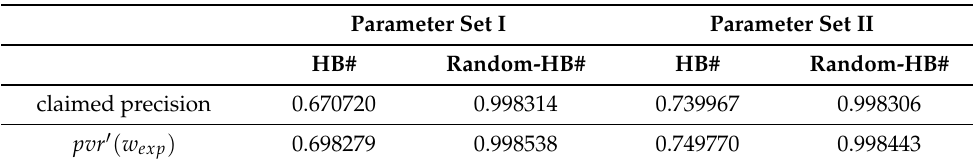
Table 7. Precision of the proposed PB-OOV algorithm meets the targeted precision for noise vector